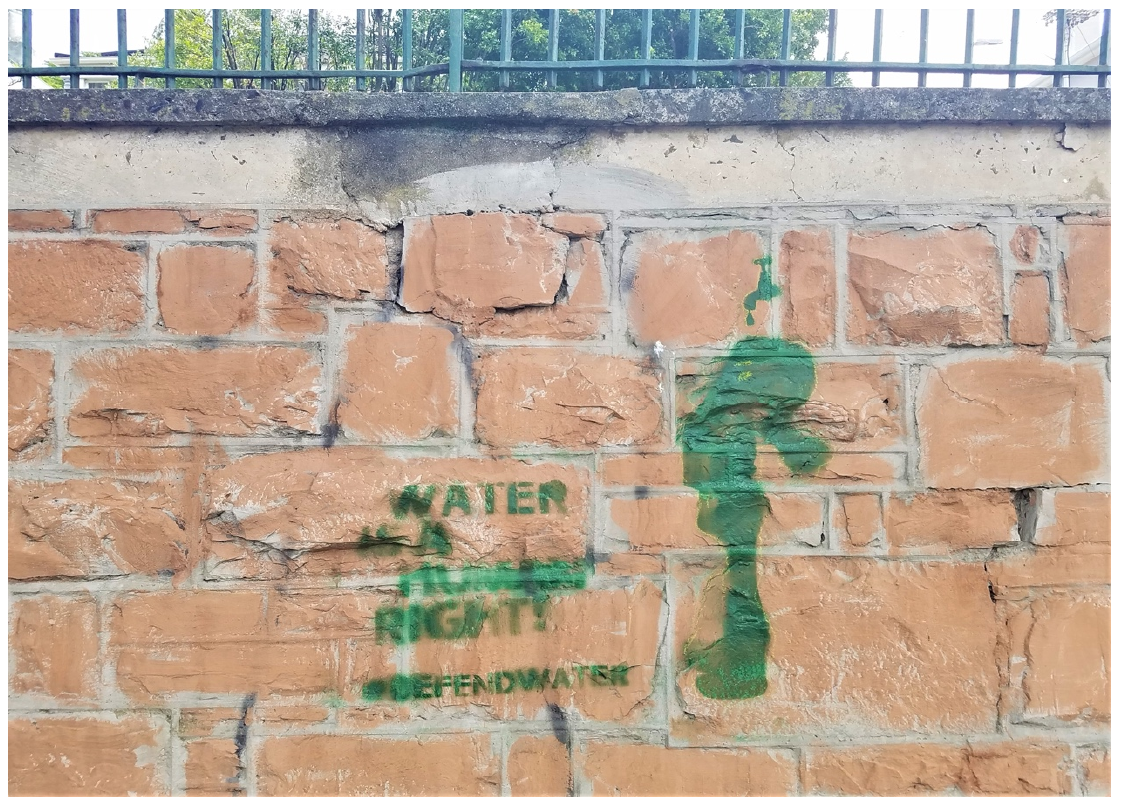
Figure 1. Cape Town street art: “WATER IS A HUMAN RIGHT: DEFEND WATER”. Photo by Natalie McCauley (January 2019), reproduced here with permission.